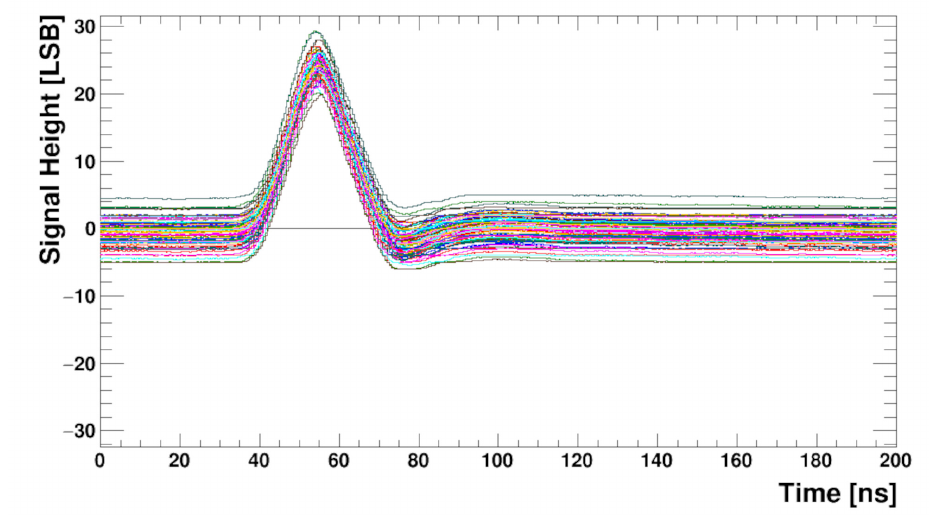
Figure 14. Pulse shapes for about 20ke input charge and 128 channels obtained from the ADCs outputs. The sensor is not connected for this measurement.